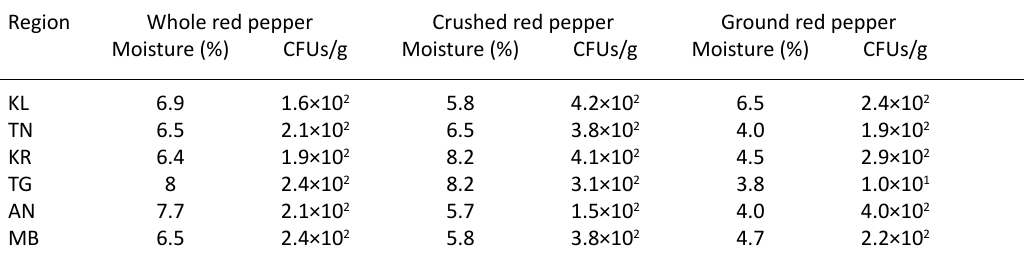
table 2. Total fungal load and moisture content of red peppers with less than two months storage Region Whole red pepper Crushed red